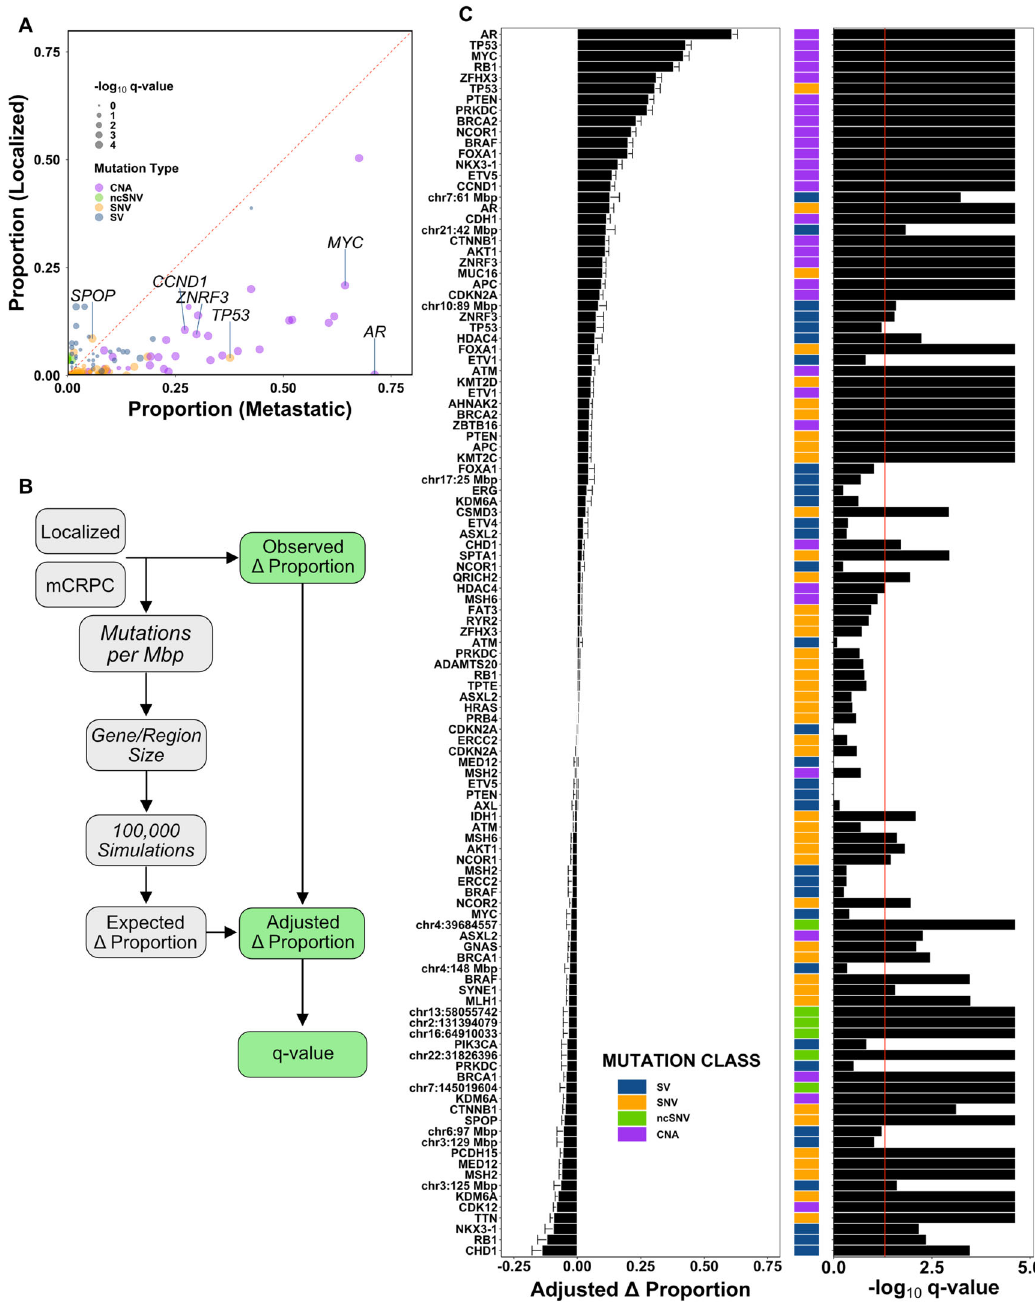
Fig. 2 Prevalence of driver gene mutations in localized and metastatic prostate cancer. A The proportion of tumors harboring each driver mutation in localized prostate cancer or mCRPC ( ‘ Observed Δ Proportion ’ ), as described. Dot size indicates − log 10 q -value; dot color indicates driver mutation type. Speci fi c genes of interest are labeled. B Comparison of driver gene mutation prevalence in localized disease and mCRPC. Differences in proportion of localized and metastatic cases harboring each driver mutation ( ‘ Observed Δ Proportion ’ ) were subtracted from the difference in proportions resulting from 100,000 simulations, per gene, per sample, where the probability of observing a mutation in a given sample was weighted by the global mutational burden (i.e. SNVs per Mb or PGA) in that sample ( ‘ Expected Δ Proportion ’ ) to generate the Adjusted Δ Proportion. A two-sided p -value was calculated as the proportion of simulated proportions that were as extreme or more extreme than the observed Δ proportion. q -values were then derived using the False Discovery Rate method. C Positive adjusted Δ proportion indicates higher than expected prevalence in mCRPC, while negative adjusted Δ proportion indicates lower than expected prevalence. Mutations are ordered from top to bottom by adjusted Δ proportion, as shown by the height of each bar. Error bars represent 95% con fi dence intervals; centre of the error bars represents the adjusted Δ proportion. Statistical signi fi cance was tested using adjusted Fisher ’ s Exact tests with correction for multiple testing using the False Discovery Rate method. Mutations with q -value < 0.05 (red line) were considered statistically signi fi cant. Source data are provided as a Source Data fi